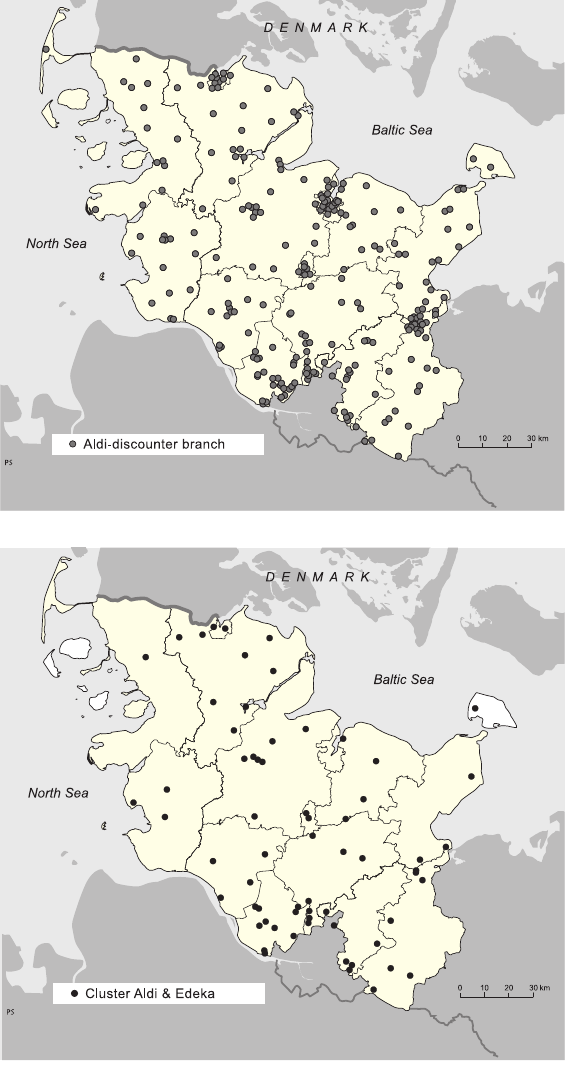
of discounters in the urban space makes the op- posite trend in rural areas all the more apparent.